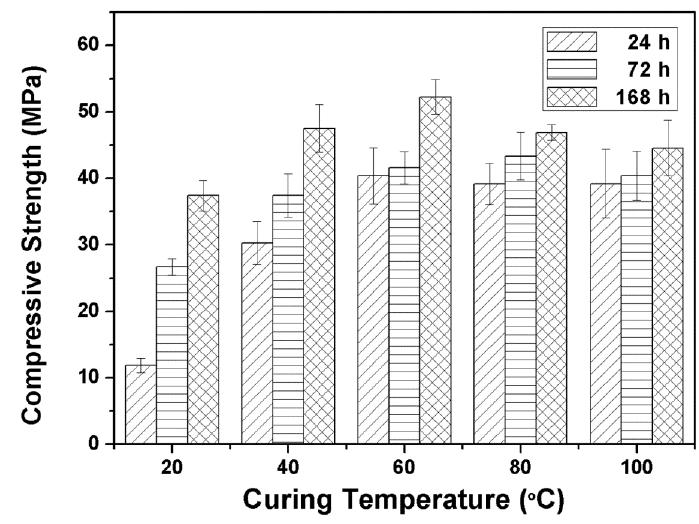
Figure 1. Effects of curing temperature and time on the compressive strength of alkali activated metakaolin-based geopolymer.